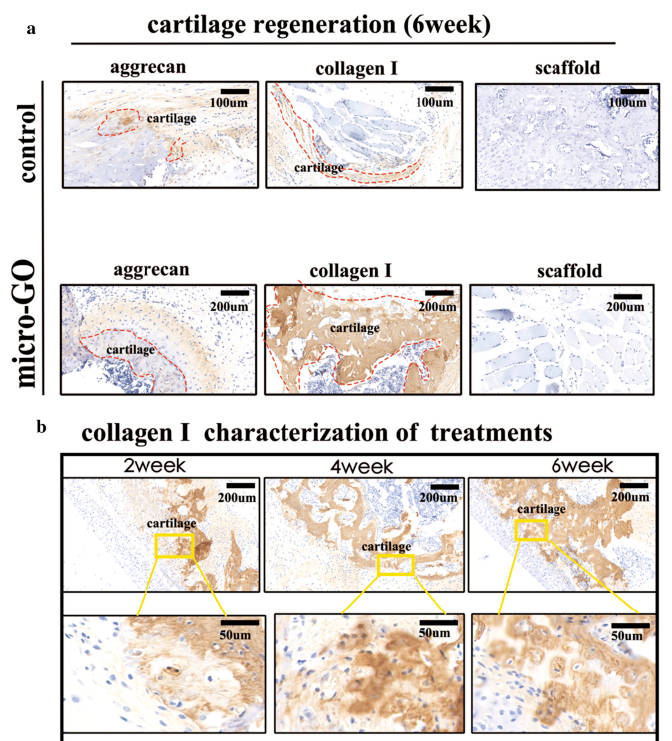
Figure 7. ( a ) Analysis of immunofluorescence staining with aggrecan and collagen I showing that the cartilage with 3D-printed scaffold only was thinner than that with micro-GO scaffold after six weeks (bar = 200 µ m). ( b ) Significant differences of immunohistochemical collagen I in treatment with micro-GO scaffold from weeks 2 to 6 (bar = 200 μ m, 100 μ m, respectively). Adapted from ref. [121].